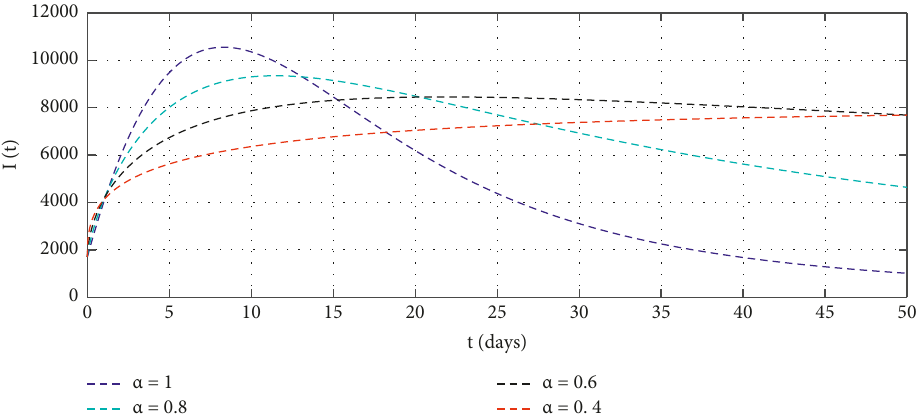
Figure 4: Simulations of infected individuals with different memory